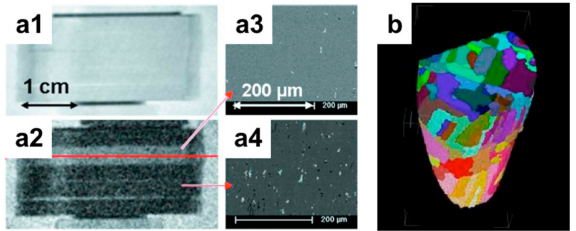
Figure 4. Qualitative dark-field imaging: ( a ) materials distinguished by scattering originating from precipitates and porosity. Reproduced from [40], with the permission of AIP Publishing; ( b ) visualizing magnetic domain walls in 3D